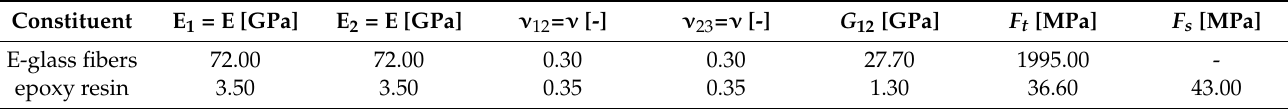
Table 1. The mechanical characteristics of the constituent materials [24,29].